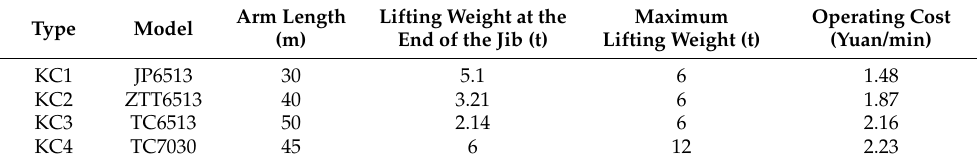
Table 2. Optional tower crane types.